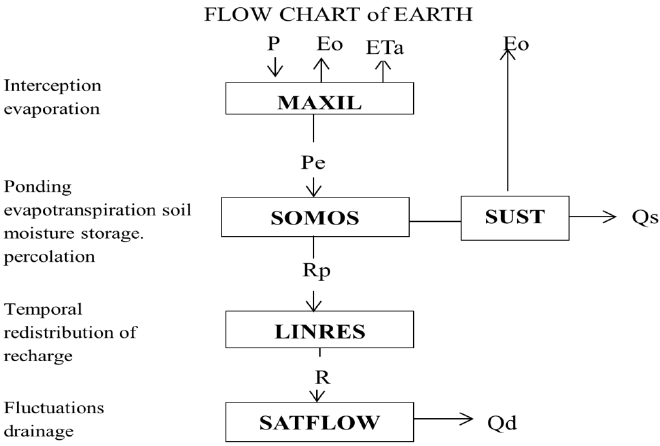
Figure 5. Flow chart of the EARTH model (modified from [19]). E 0 = potential evapotranspiration, ETa = actual evapotranspiration, P = precipitation, Pe = precipitation excess, Rp = percolation, R= recharge, Qs = surface runoff, and Qd = drainage runoff.